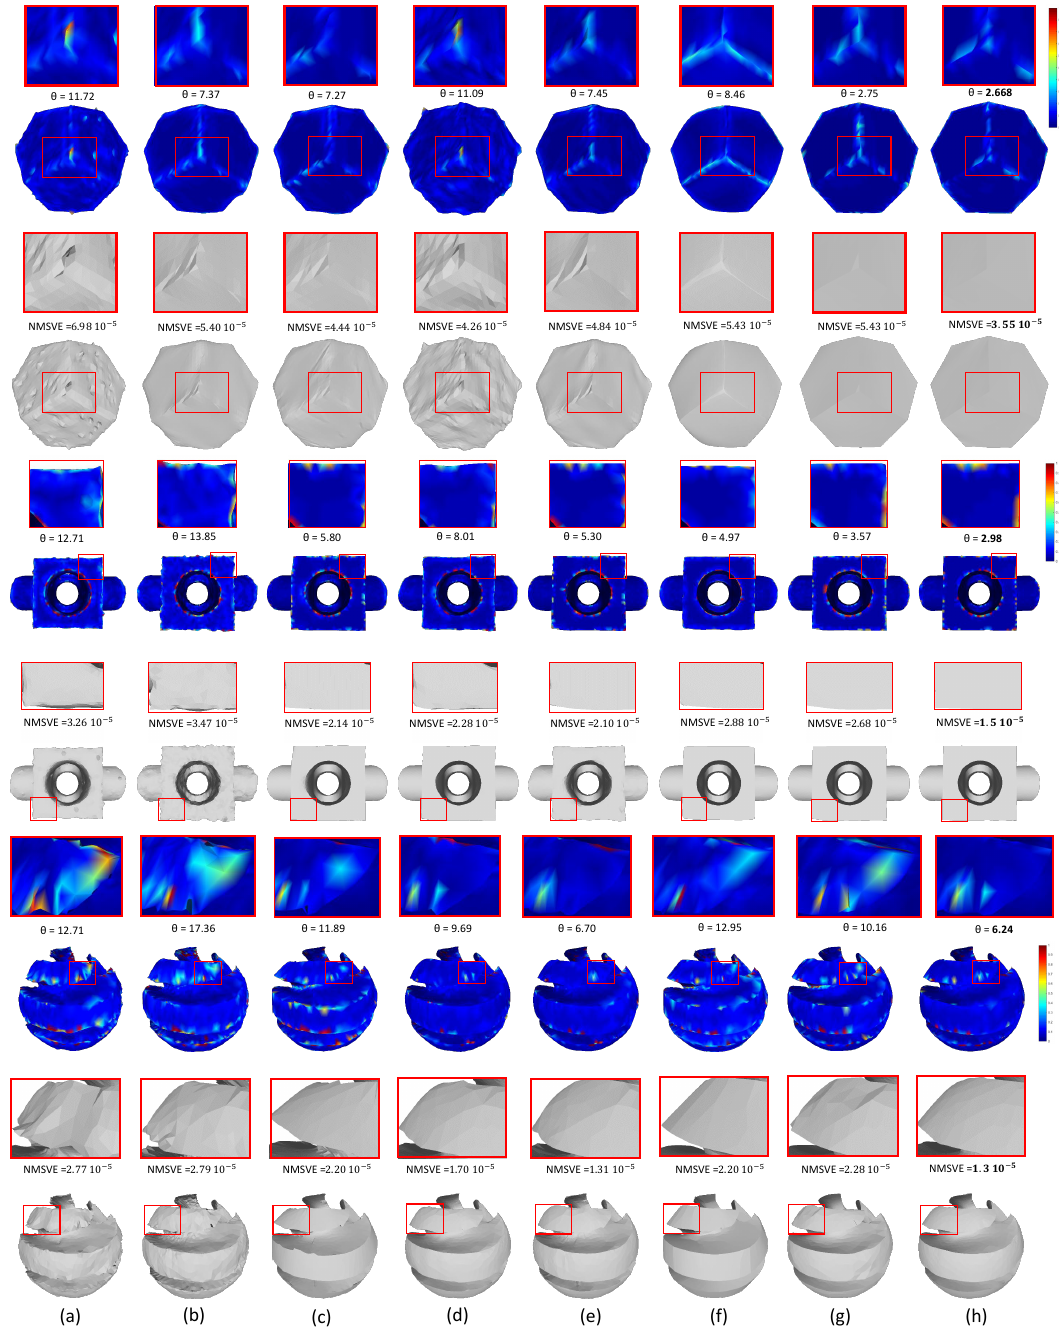
Figure 17. Denoising results for different methods and heatmap visualization; ( a ) bilateral [41]; ( b ) non-iterative [45]; ( c ) Fast and Effective [46]; ( d ) Bilateral (l) [42]; ( e) Bilateral ( g ) [42]; ( f ) l 0 minimization [47]; ( g ) Guided normal filtering [43]; ( h ) Our